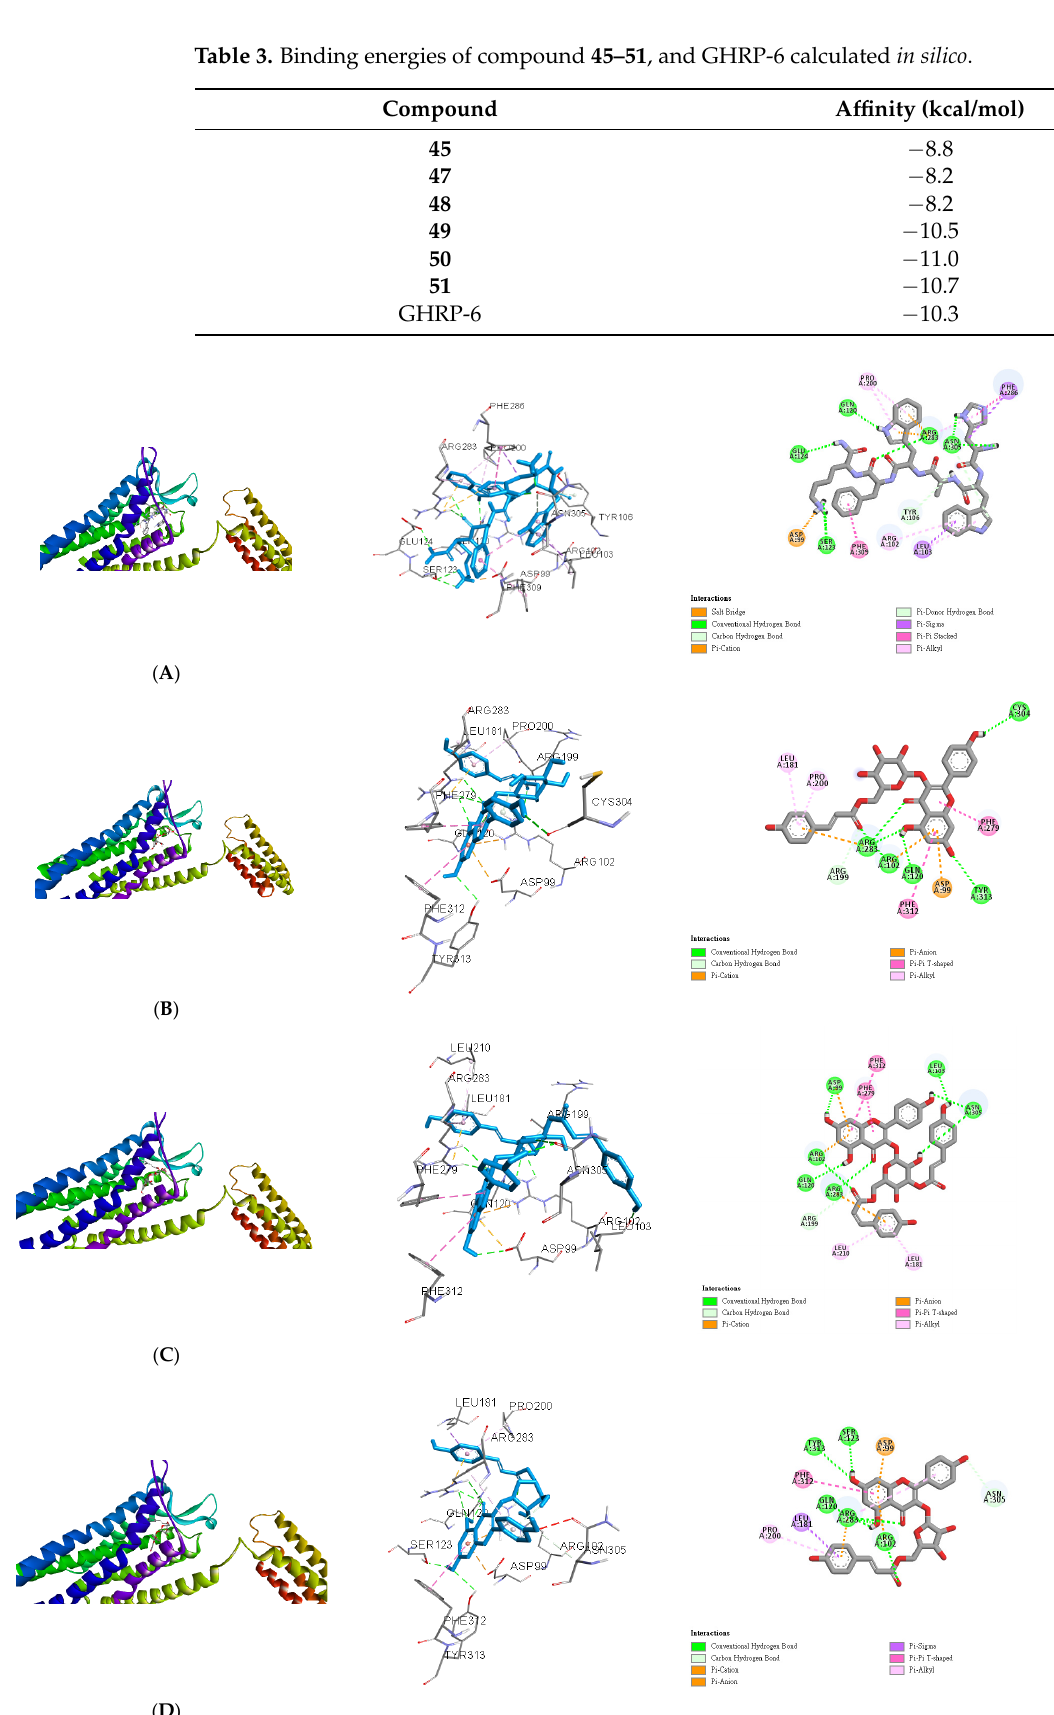
Figure 3. In silico modeling of ( A ) GHRP-6, ( B ) 49 , ( C ) 50 , and ( D ) 51 docking into the ghrelin